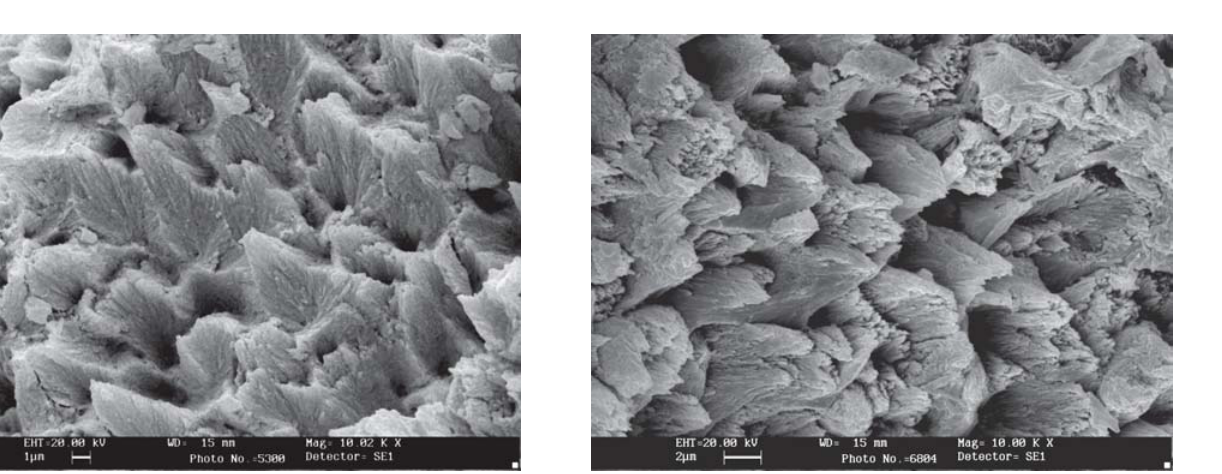
FIGURE 2- Fractured enamel surface of unbleached specimens stored in artificial saliva. Cone-like and protruding prisms indicate a typical fracture pattern that occurs transversally to prismatic orientation of the sound enamel